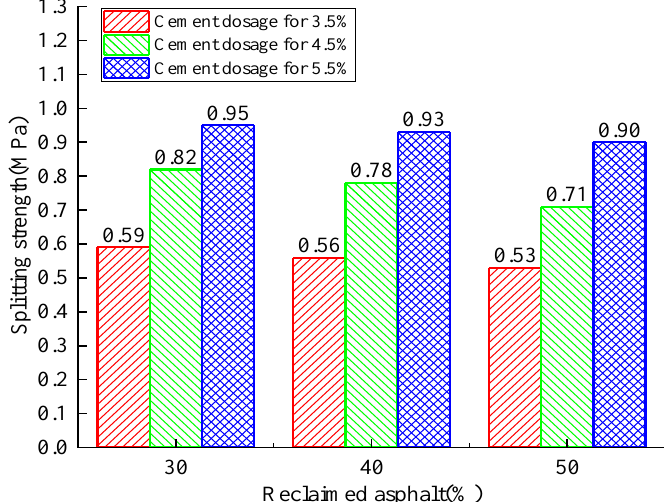
Figure 13. Analysis of the 90-day reclaimed asphalt splitting tensile-strength test with variation of cement dosage and RAP.